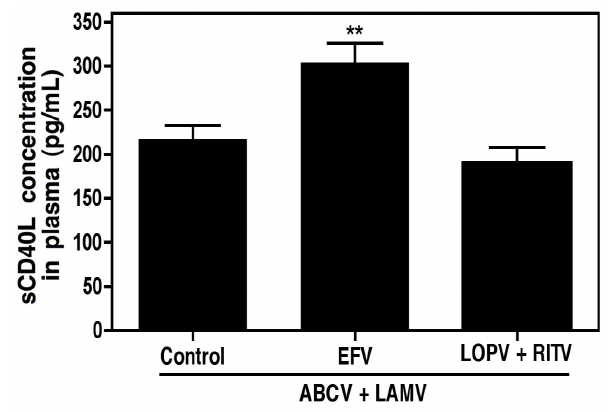
Figure 1. Efavirenz, a non-nucleoside reverse transcriptase inhibitor (NNRTI), results in accumulation of sCD40L in HIV infected individuals. Plasma sCD40L levels were analyzed in HIV infected individuals receiving combination antiretroviral therapy in- cluding NRTIs (abacavir, ABCV, and lamivudine, LAMV; Control, n=12) and either an NNRTI (efavirenz, EFV; n=13) or protease inhibitor cocktail (lopinavir, LOPV, and ritonavir, RITV; n=10). The values were compared via one-way ANOVA followed by Bonferroni’s test for multiple comparisons, which indicated statistical significance as **p ,